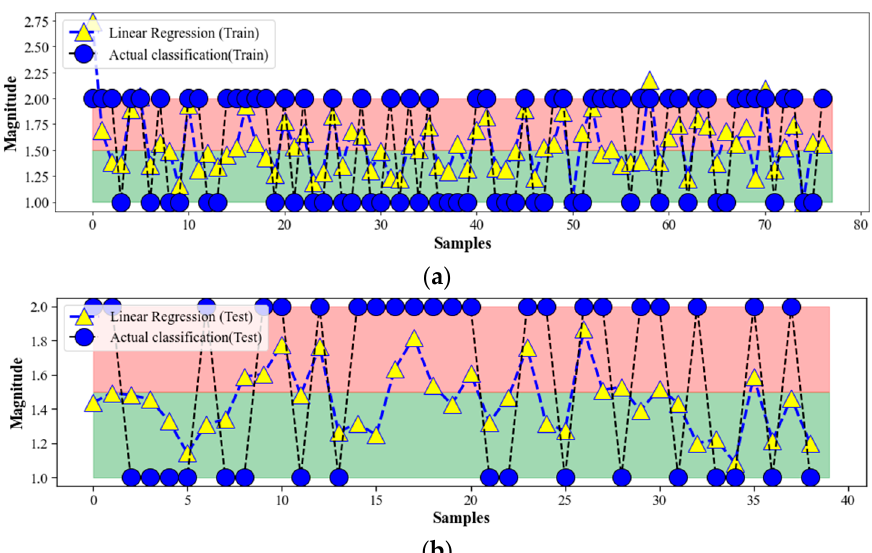
Figure 2. The procedure of identifying breast cancer is illustrated for both the training and testing data based on ML linear regression. ( a ) The effectiveness of the procedure is measured using the training data. ( b ) The procedure’s performance is assessed using the testing